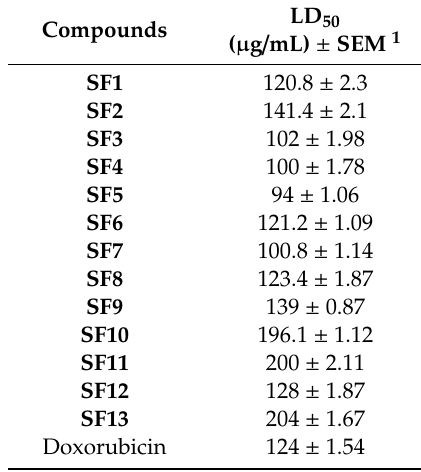
Table 3. Cytotoxicity of compounds ( SF1 – SF13 ) using brine shrimp lethality bioassay.